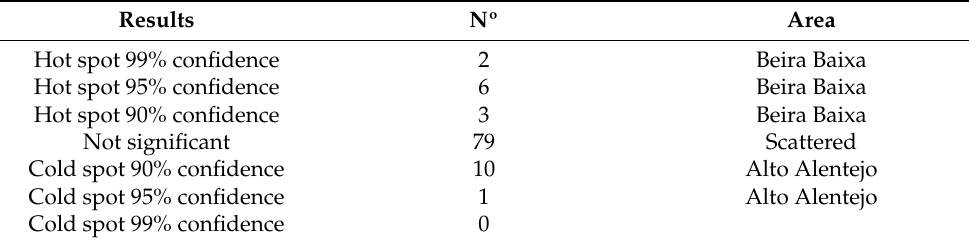
Figure 7. Hot Spot analysis results for global sustainability indicators. Source: authors’ own material from calculations carried out using ArcGIS 10.8. Table 11. Results of the hot spot analysis for global sustainability